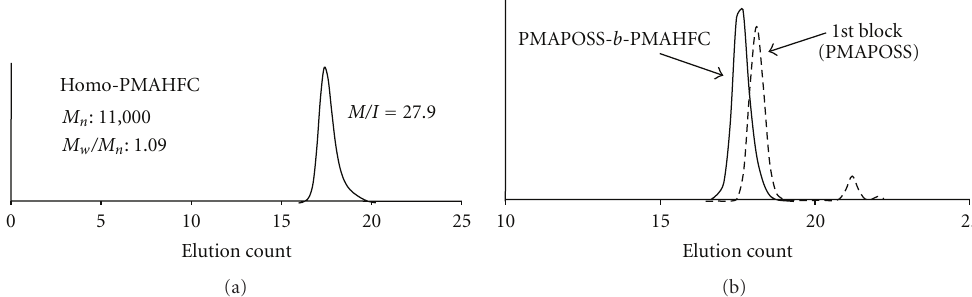
Figure 5: SEC curves of (a) PMAHFC homopolymer and (b) PMAPOSS- b -PMAHFC (solid line) and PMAPOSS (dashed line).